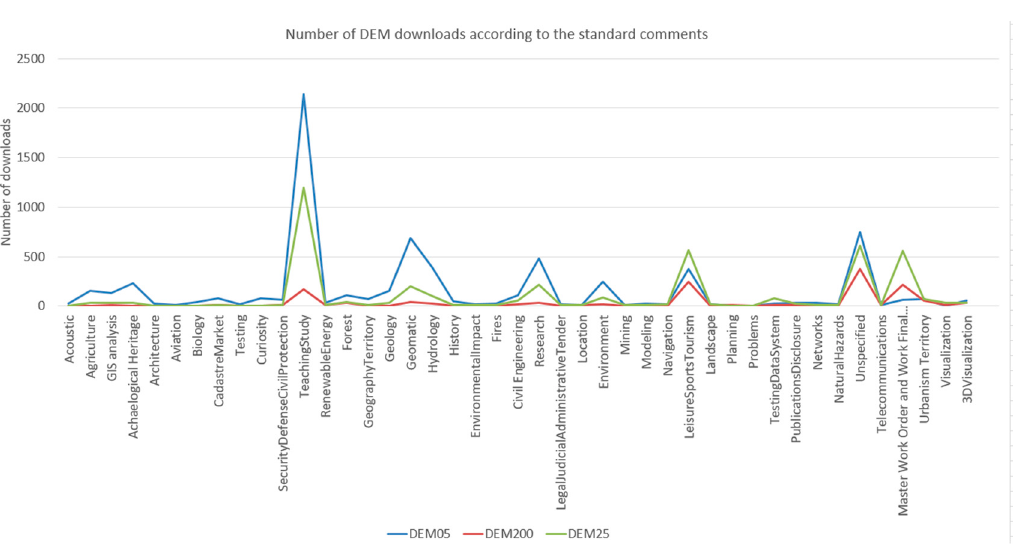
Figure 10. Number of DEM downloads according to the standard comments.